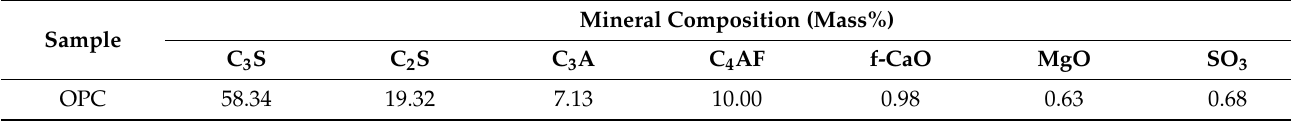
Table 2. Mineral composition of Portland cement CEM I 42.5 N given by the producer.